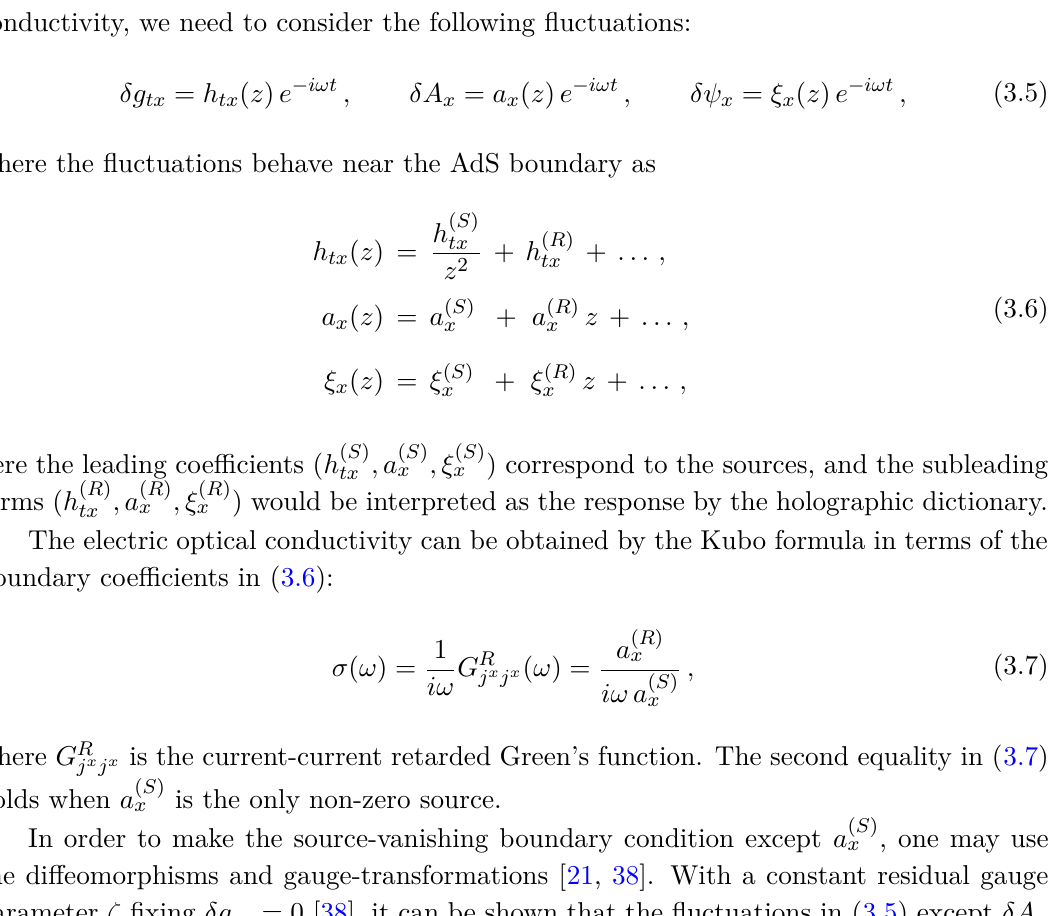
Figure 2 . Condensation vs temperature at τ = 1 / Holographic electric optical